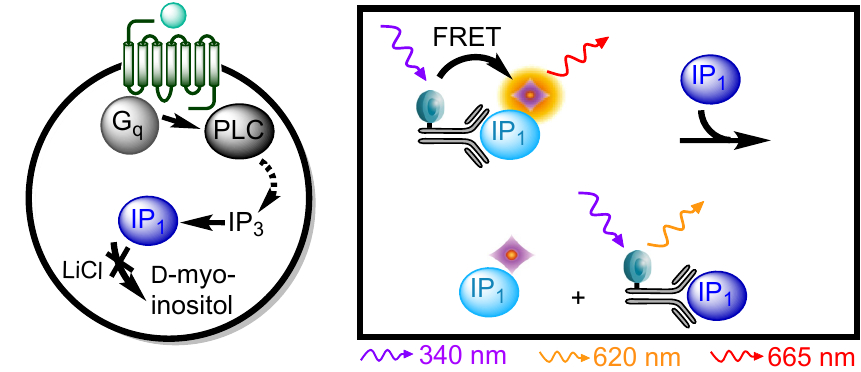
Figure 2. IP-One assay principle. ( Left ) Upon ligand stimulation of the GPCR activation protein occurs through activation of phospholipase C (PLC) leading to the formation of the G q of inositol 1,4,5-trisphosphate (IP ). IP is degraded into IP and then D -myo-inositol in a 3 3 1 rapid manner. LiCl inhibits this last step in the degradation; ( Right ) The endogenous IP 1 competes with acceptor-labeled IP for the binding sites of a donor-labeled IP 1 1